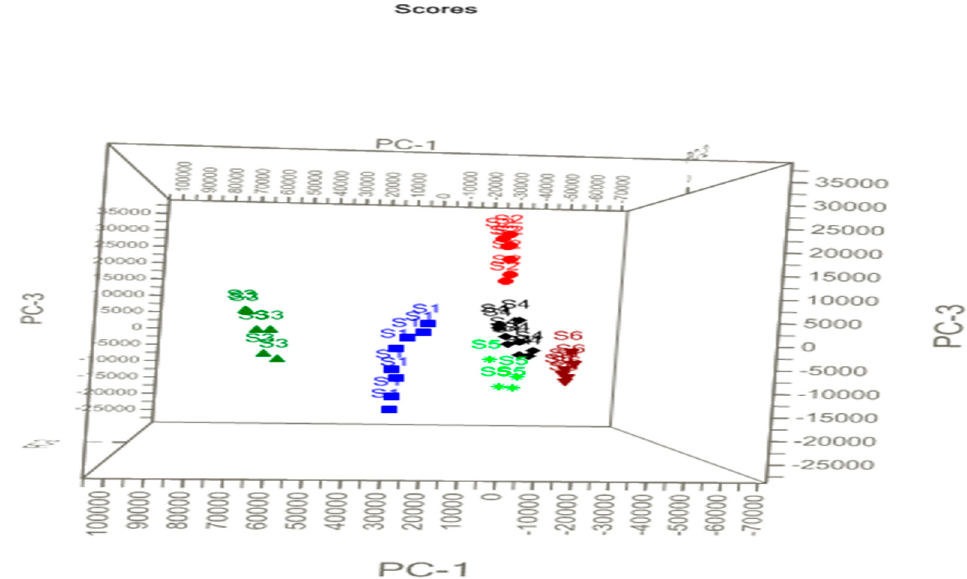
Figure 5. Principle component scatter (PCA) plot of the drugs in three dimensions. PC-2 axis is perpendicular to the plane of this page.